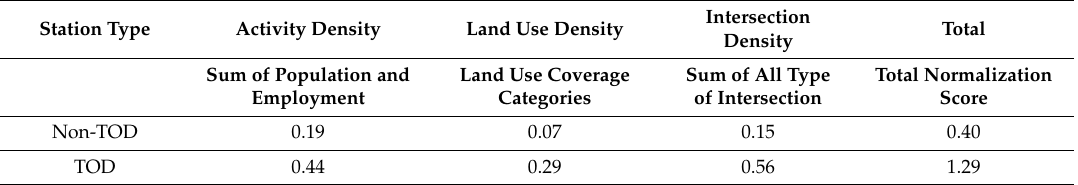
Table 1. Variables for station